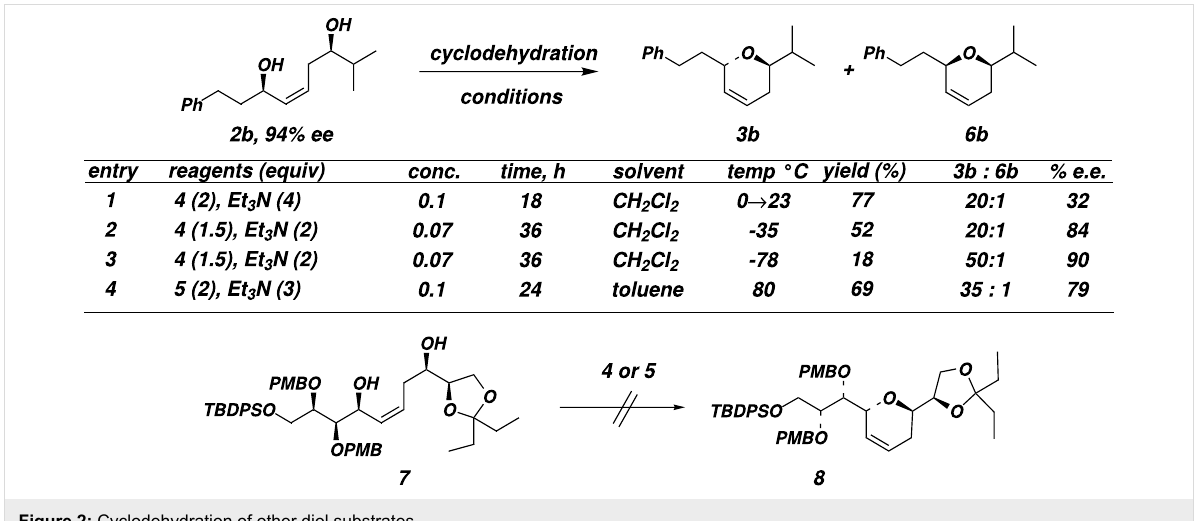
for the activated allylic alcohol to be displaced in this intramolecular substitution process, the allylic C-O bond substantially deviates from coplanarity with the adjacent π-system. Therefore, the difference in relative rates of displace- ment of the two activated hydroxyl groups is much less than originally anticipated. The enantioselectivity could be increased to 90% by lowering the reaction temperature to -78°C, but the yield of dihydropyran 3a was reduced to less than 50% (entry